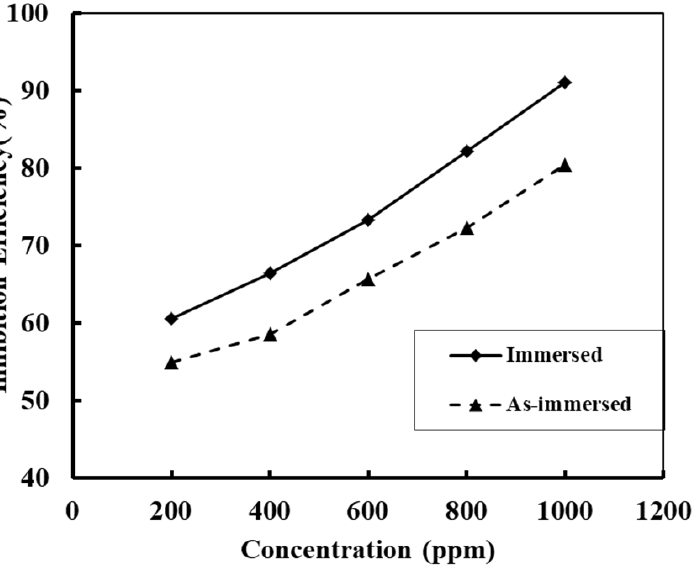
Figure 15. Inhibition efficiency of inhibitor obtained from the polarization of both immersed and as-immersed MS sample 1 M H 2 SO 4 in the presence of ST alkaloid as an inhibitor. Figures 14 and 15 revealed that the inhibition efficiency increases with an increase in covered by mild steel by the adsorbed molecule, which results in the increase in inhibition efficiency on the increasing concentration of inhibitor